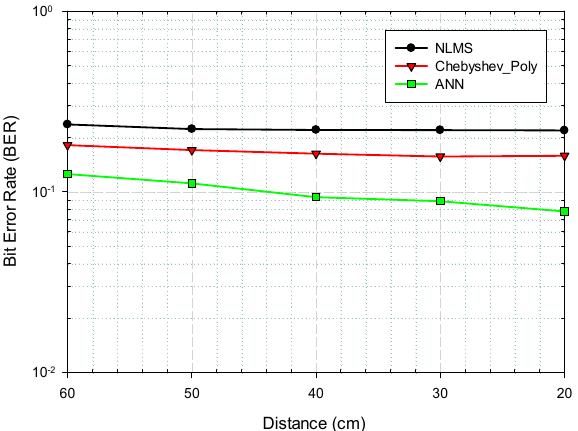
Figure 13. BER versus the distance between the LED and the PD of the 16 QAM modulated OFDM for the NLMS, the Chebyshev polynomial, and the proposed ANN predistortion.